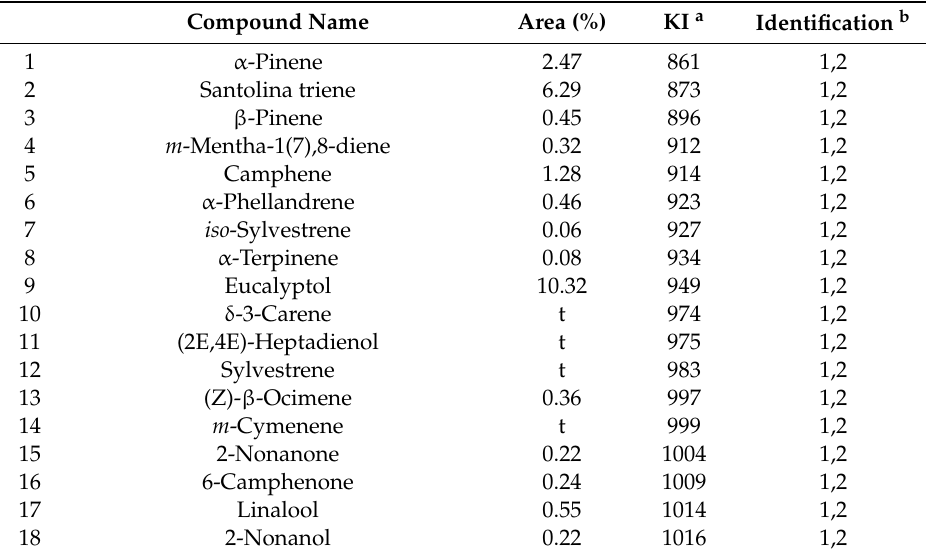
Table 3. Chemical composition of Z. o ffi cinale L. rhizome